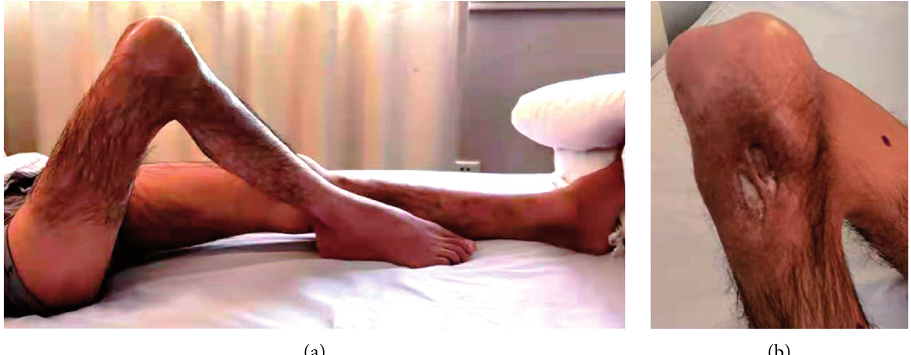
Figure 3: (a) Lateral photography of Patient 3 in supine position before amputation. (b) Partial photography of posterior side of Patient 3’s right knee.